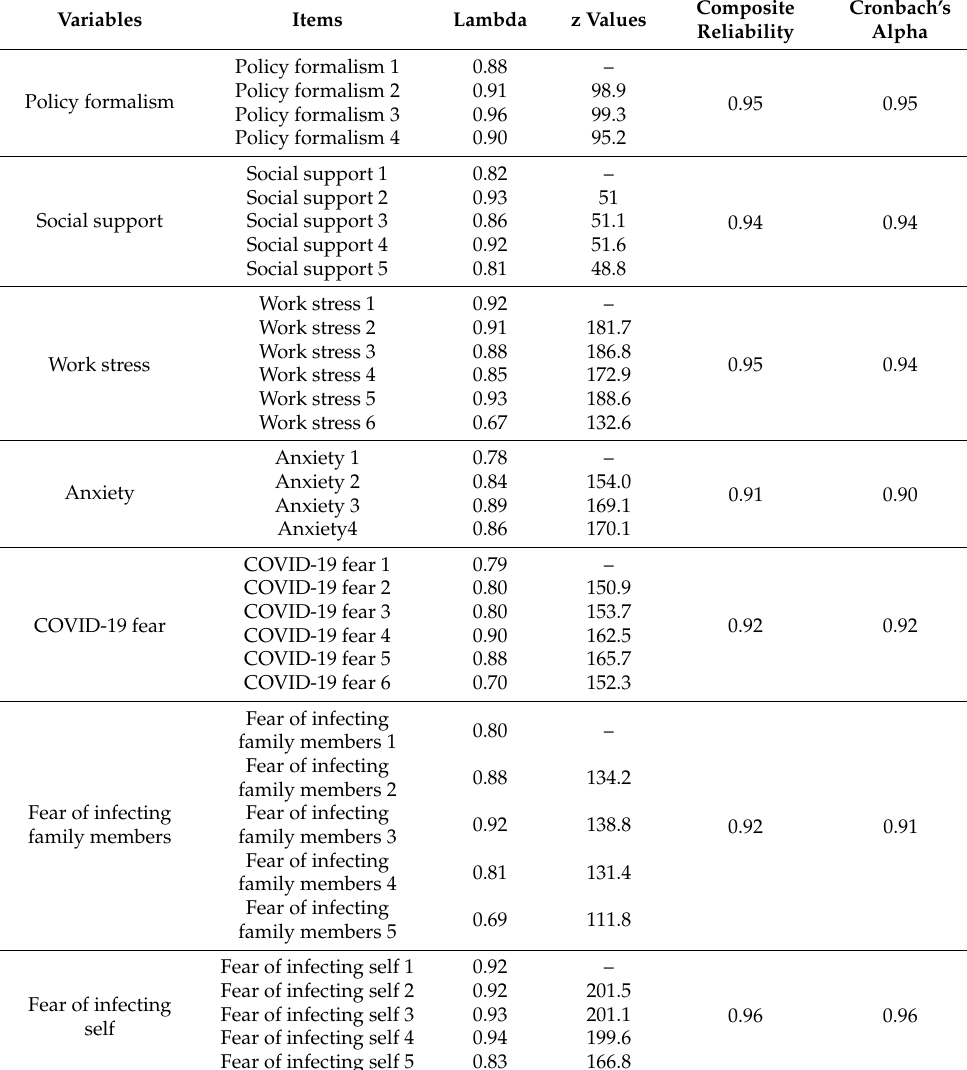
Table 2. Item loading and model